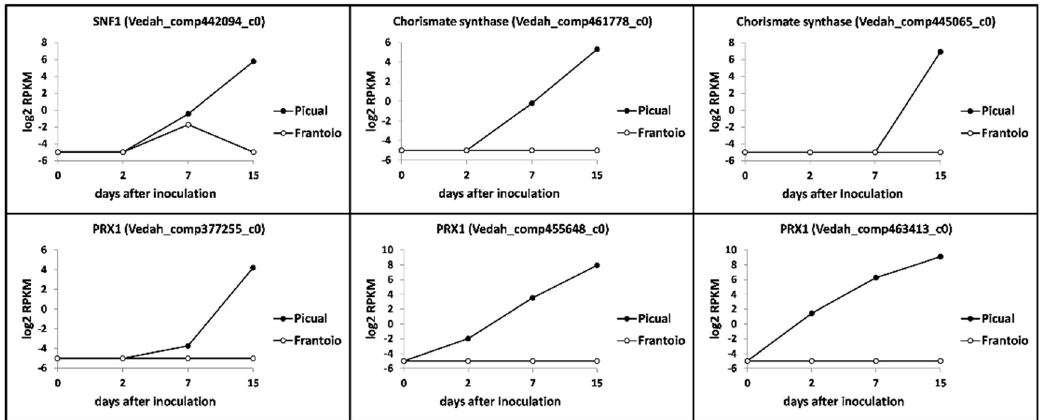
Figure 6. Verticillium dahliae unigenes related to niche adaptation and differentially expressed in ‘Picual’ and ‘Frantoio’ roots during infection. Samples were analyzed by RNAseq (see the Results section for details). RPKM, Reads Per Kilobase Million.